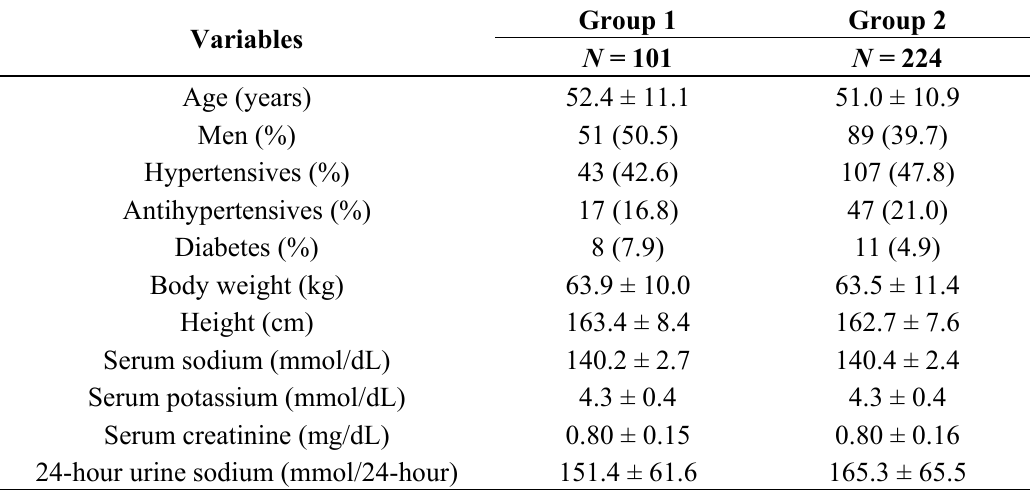
Table 1. Demographic and clinical characteristics of the study population.